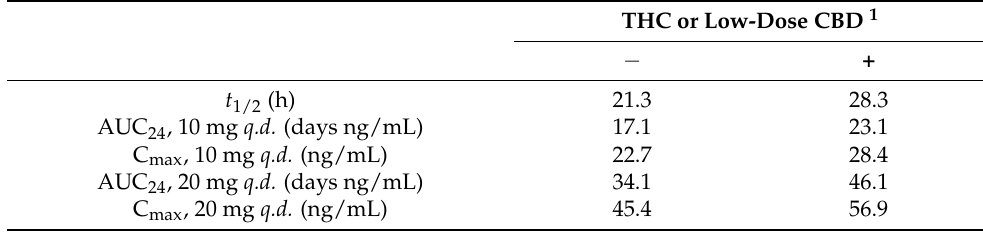
Table 2. Pharmacokinetic parameters at steady state for a model escitalopram normal metabolizer with concurrent cannabinoid use assuming a 25% reduction in clearance based on Bansal et al. [31].